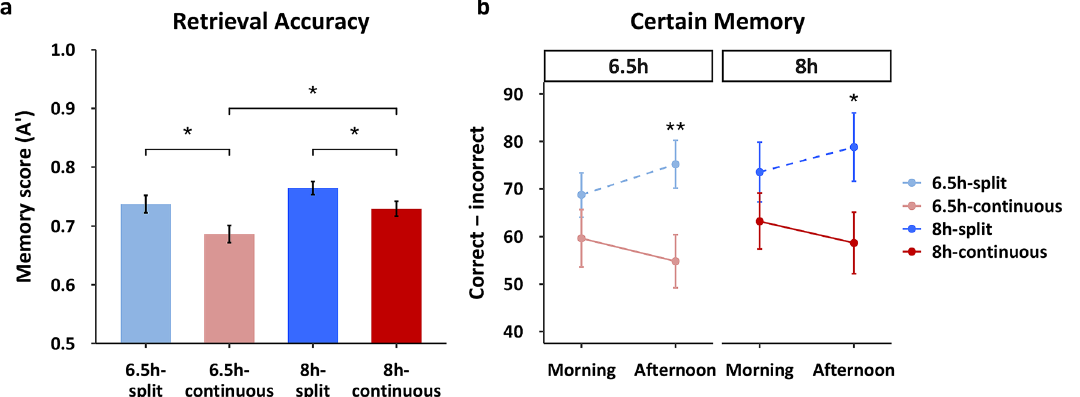
Figure 3. Memory performance. ( a ) Splitting sleep led to significantly better picture recognition (A’) for both the 6.5 h and 8 h durations, indicating a benefit of the nap for subsequent encoding. A longer sleep duration also provided better memory for groups that slept only nocturnally (8 h-continuous vs. 6.5 h-continuous), but duration did not significantly influence memory on the split sleep schedule (8 h-split vs. 6.5 h-split). Memory performance was similar between the 8 h-continuous and the 6.5 h-split groups. ( b ) For the factual knowledge task, splitting sleep also provided significantly better memory (certain correct–incorrect) for species learned in the afternoon for both 6.5 h and 8 h durations. Memory for species learned in the morning did not differ between groups. Together this suggests that a split sleep schedule benefits afternoon learning with no “cost” to morning learning. Mean ± standard error of the mean (SEM). *p < 0.05, **p <